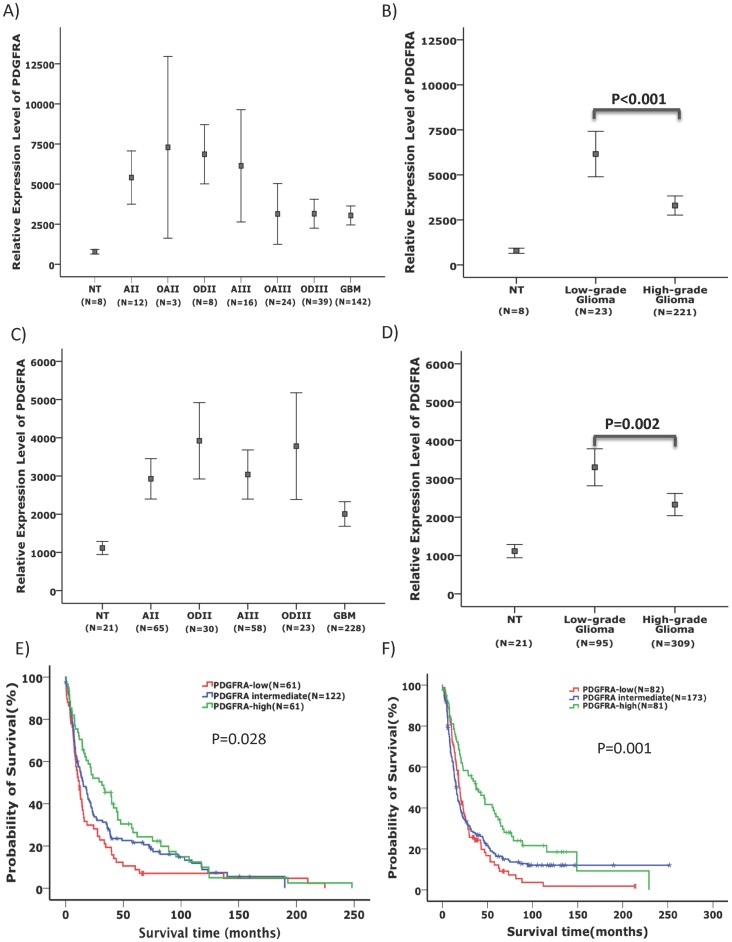
Differential expression of PDGFRA in glioma subtypes and its association with patient survival time.In both GSE16011 (A, B) and Rembrandt (C, D) data sets, PDGFRA expression (Mean ± 2 SEM, SEM: standard error of the mean) was highly variable among the samples of each morphological subtype (A and C. NT: non-tumor; AII, astrocytoma grade II; AIII: astrocytoma grade III; GBM, glioblastoma; OD: oligodendroglioma; OA: oligoastrocytoma). Low-grade gliomas showed significantly higher levels of PDGFRA expression compared to high-grade gliomas (B and D). Kaplan-Meier plots showed that in both GSE16011 (E) and Rembrandt (F) data sets, the survival of patients with the upper 25% PDGFRA expression (PDGFRA-high) in glioma samples irrespective of their morphological diagnosis was significantly longer compared with those glioma patients with PDGFRA expression at the lowest 25% (PDGFRA-low) and the intermediate 50% (log-rank test).